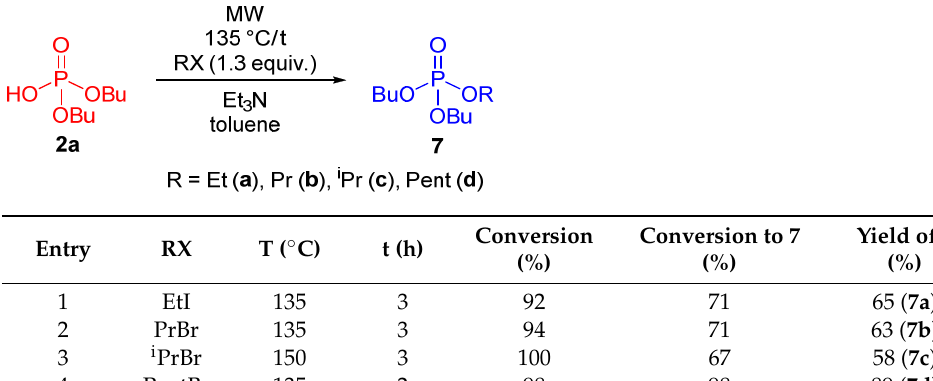
Table 4. Alkylating esterification of dibutylphosphate ( 2a ) with alcohols under MW conditions.